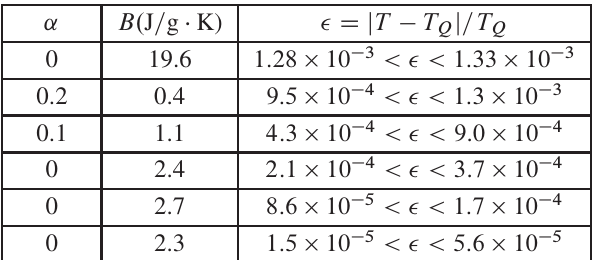
Table 4. Values of the critical exponent ˛ for the specific heat C p and the amplitude B within the temperature in- terval (cid:4) for the ˛ - ˇ phase transition ( T Q D 577:1 ı C) in quartz according to Eq. (1) where A D 1:2 J = g (cid:3) K. The experimental C p data [2] was analyzed below T Q along cooling